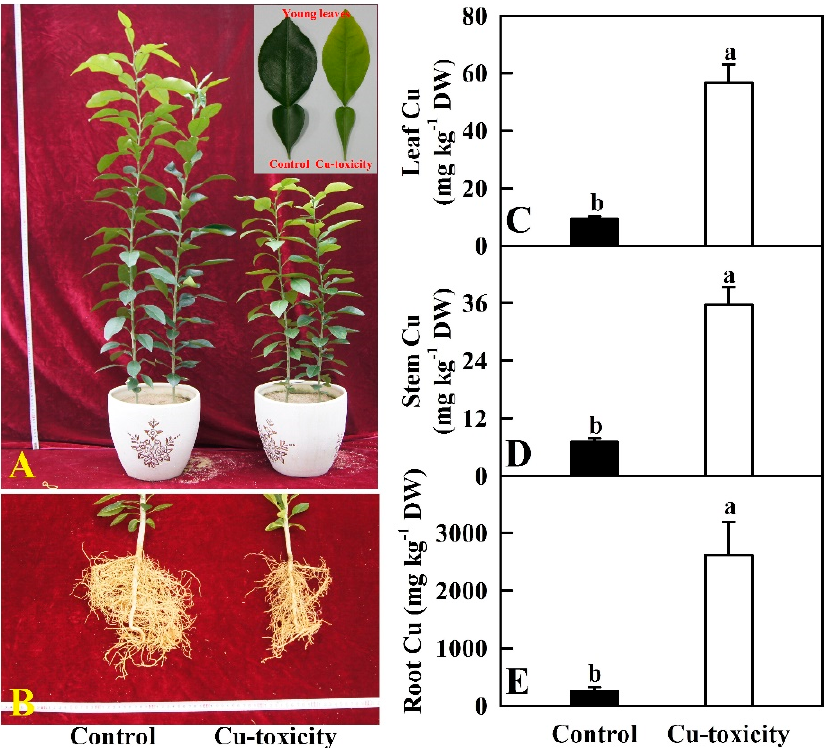
Figure 1. Cu-toxic effects on shoot ( A ) and root ( B ) growth, and mean (SE, n = 4) concentrations of Cu in leaves ( C ), stems ( D ) and roots ( E ). Different letters above the bars indicate a significant difference at p < 0.05.